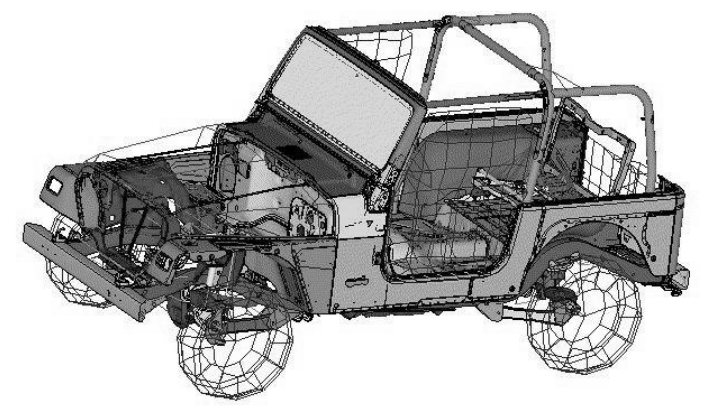
Fig. 1. Full system finite element model of a 4WD Sport Utility Vehicle.